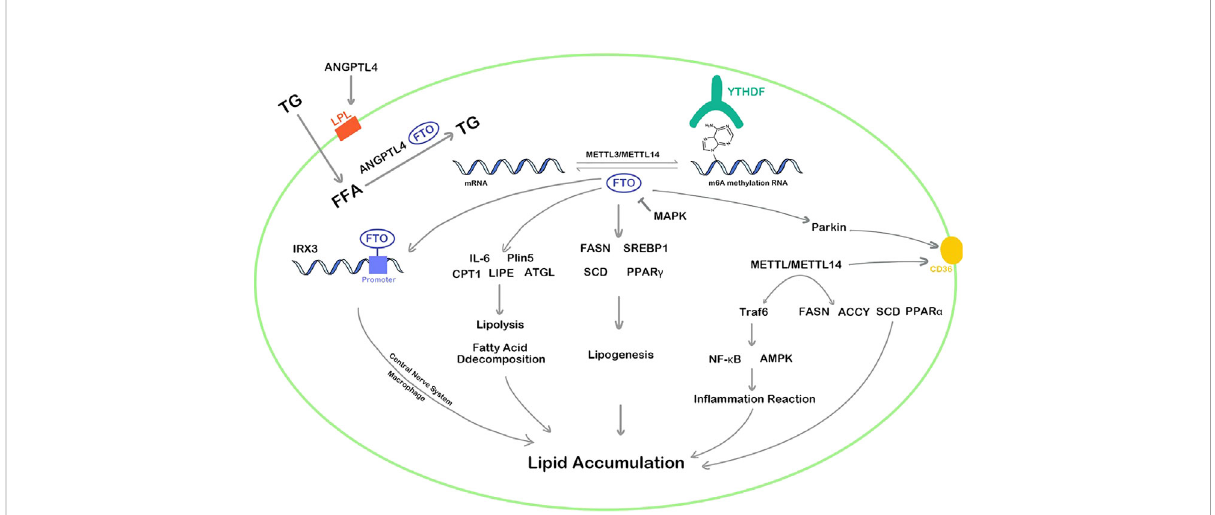
FIGURE 2 RNA m6A regulators in fl uence lipid cellar accumulation in various ways. TG, triglyceride; ANGPTL4, angiopoietin-like protein 4; IRX3, iroquois homeobox protein 3; MAPK, mitogen-activated protein kinase; FFA, free fatty acid; IL-6, interleukin 6; Plin5, perilipin5; CPT1, carnitine palmitoyltransferase 1; LIPE, hormone-sensitive lipase; ATGL, adipose triglyceride lipase; PPAR, peroxisome proliferator-activated receptor; FASN, fatty acid synthase; LPL, lipoprotein lipase; SREBP1, sterol regulatory element-bindin protein-1; SCD, stearoyl-CoA desaturase; Traf6, TNF receptor associated factor 6; ACCY, acetyl-CoA carboxylase; NF- k b, nuclear factor kappa-B; AMPK, adenosine 5 ’ -monophosphate-activated protein kinase.